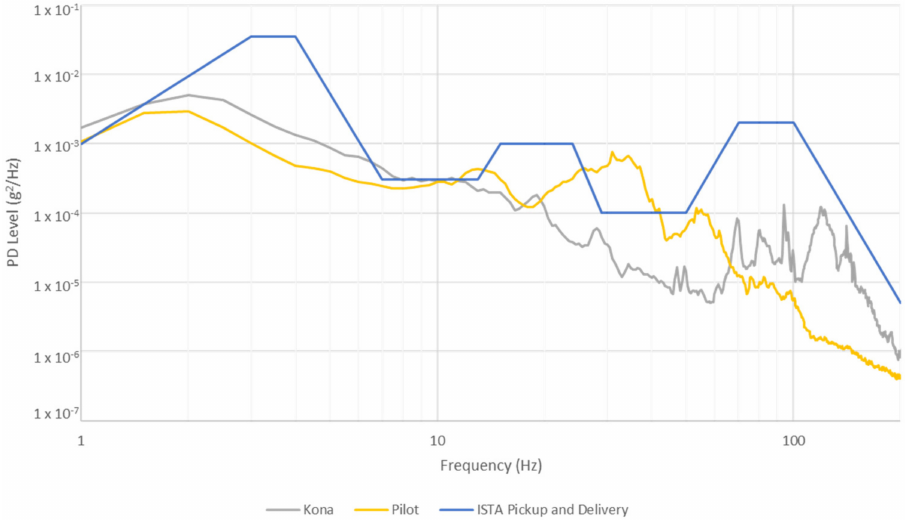
Figure 7. PSD plot comparison with current package testing